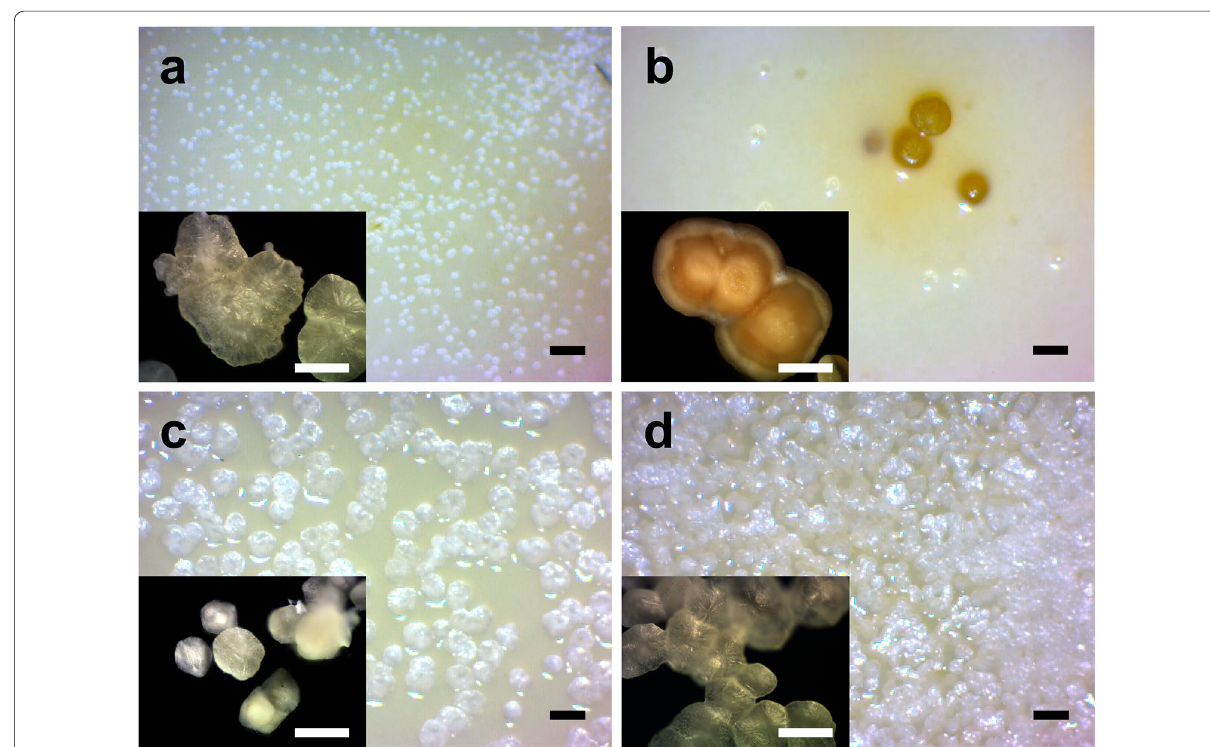
Fig. 1 Cultures of B. subtilis and mineralized cell colonies formed in coupled and non‑coupled calcium‑carbon sources media. Images show stereoscopic view of plates and metallographic micrographs of recovered composites from a GLY, b GLC, c LAC, and d ACE media. Scale bars: 1 mm (black); 100 μm